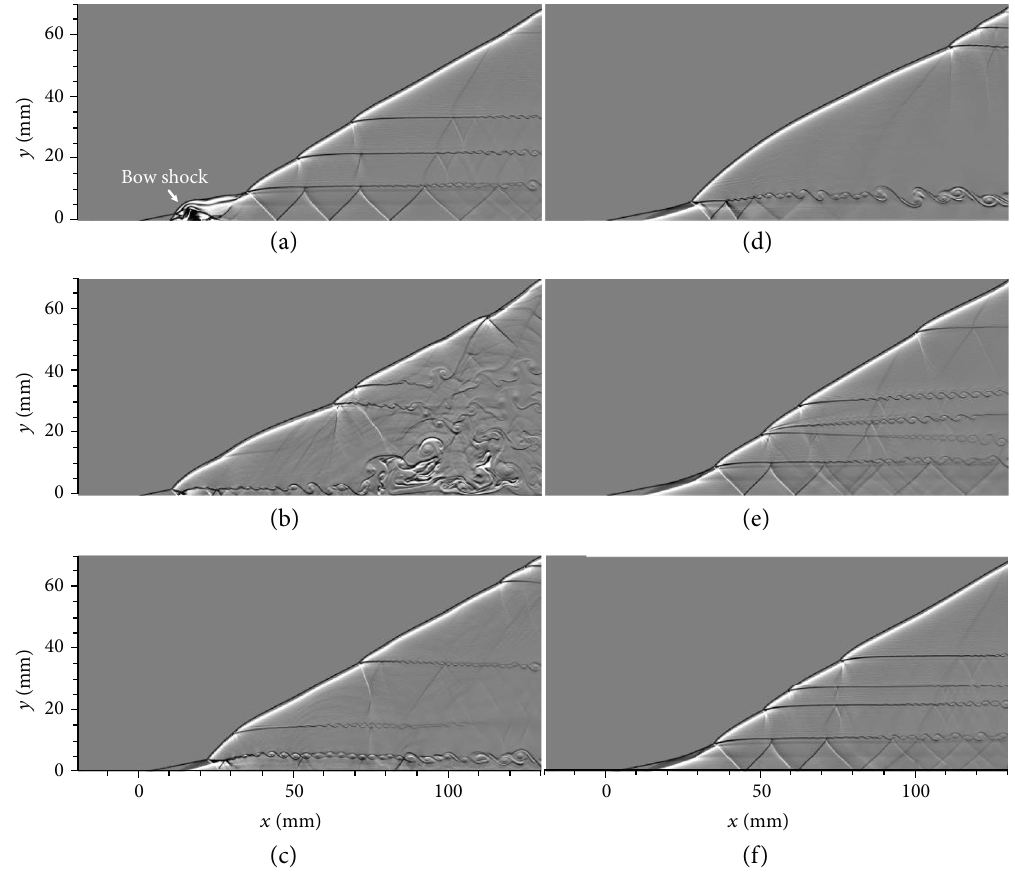
Figure 4: Evolution of the fl ow fi eld after DJFD of 100 Δ t at θ = 32 ∘ . (a) t = 100 Δ t (the jet fl ow has just been turned o ff ), (b) t = 900 Δ t , (c) t = 2100 Δ t , (d) t = 5700 Δ t , (e) t = 16200 Δ t , and (f) steady state after the disturbance.